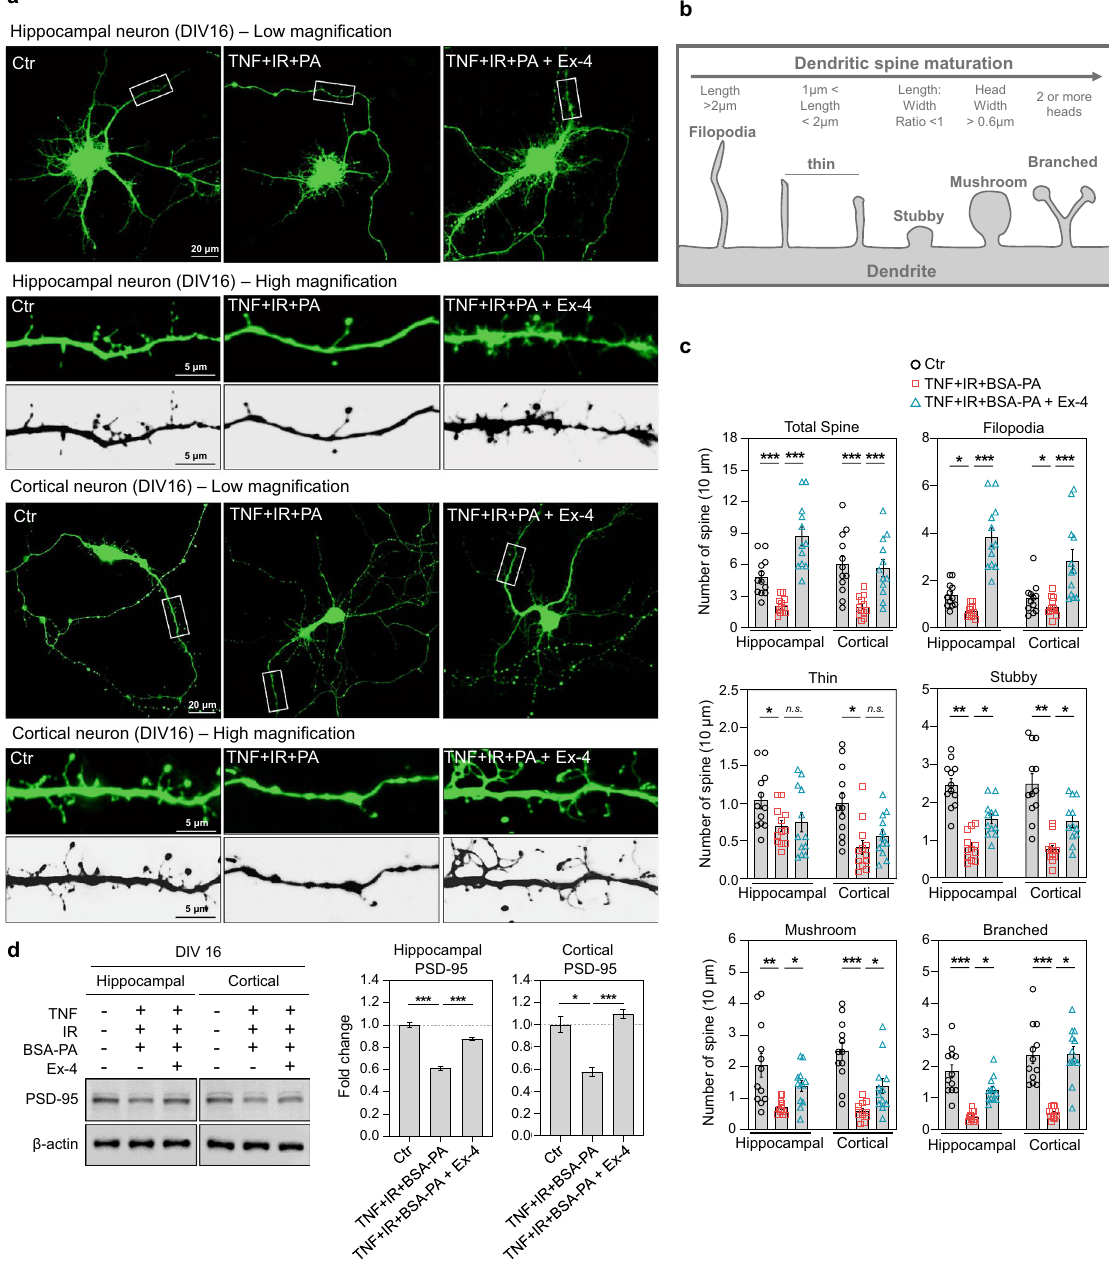
Figure 2. Exendin-4 changes the dendritic spine shape and protein dynamics related to synaptic function in neurons in metabolic imbalance conditions. ( a ) Representative images at low- (×40) and high-magnification (×120) of GFP-positive primary hippocampal and cortical neurons at DIV 16 after treatment of the metabolic imbalance inducing factors such as TNF-α, insulin, glucose, palmitate, and a therapeutic agent exendin-4. The original location of the high-magnification images is indicated by the rectangular box outlined in white in the low magnification images. ( b ) Schematic drawing for the dendritic spine maturation process. Parameters such as the length and width for definition of the spine shape are indicated. ( c ) Histogram for the changes in the shape of the dendritic spine after treatment of metabolic imbalance inducing factors and a therapeutic agent exendin-4 into primary hippocampal and cortical neurons at DIV 16. The number of spine types in the dendrite of 10 μm length was counted to represent the mean. ( d ) The measurement and histogram of the expression of a protein related to synaptic function, PSD-95, after treatment of metabolic imbalance inducing factors and a therapeutic agent exendin-4 into primary hippocampal and cortical neurons at DIV 16. Data information: Ctr.: control, TNF: 25 ng/ml TNF-α, IR: insulin resistance (treatment of 100 nM insulin and 4.5 g/L d-glucose), BSA-PA: 50 μM BSA-conjugated palmitate, Ex-4: 10 nM exendin-4. The length of the scale bar is included in the representative images. Data are expressed as the group mean ± standard error of the mean. In ( a ) and ( c ), data are expressed from 12 neurons per independent group in triplicate. In ( d ), data are expressed from three independent experiments in triplicate. Statistical analyses examined the relative significance between each group (unpaired two-tail t -test with Welch’s correction). n.s. P > 0.05, *P < 0.05, **P < 0.01, and ***P <